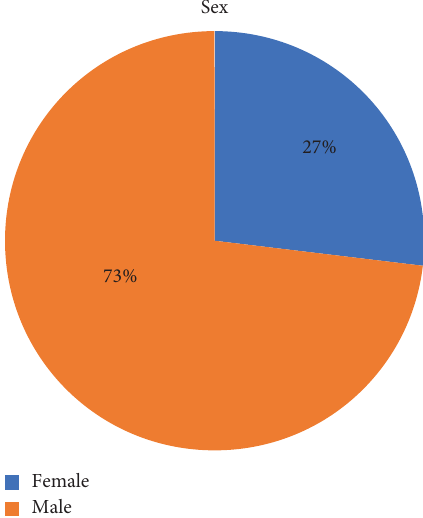
Figure 1: Sex distribution of